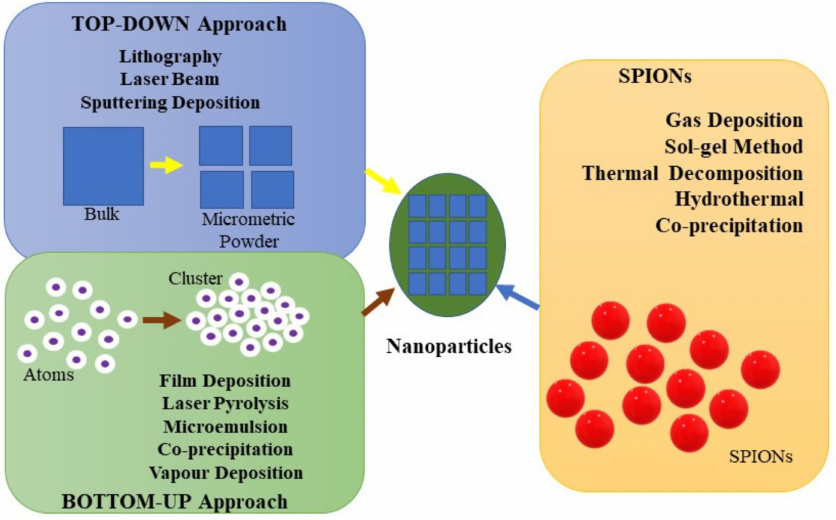
Figure 1. Nanoparticle’s synthesis